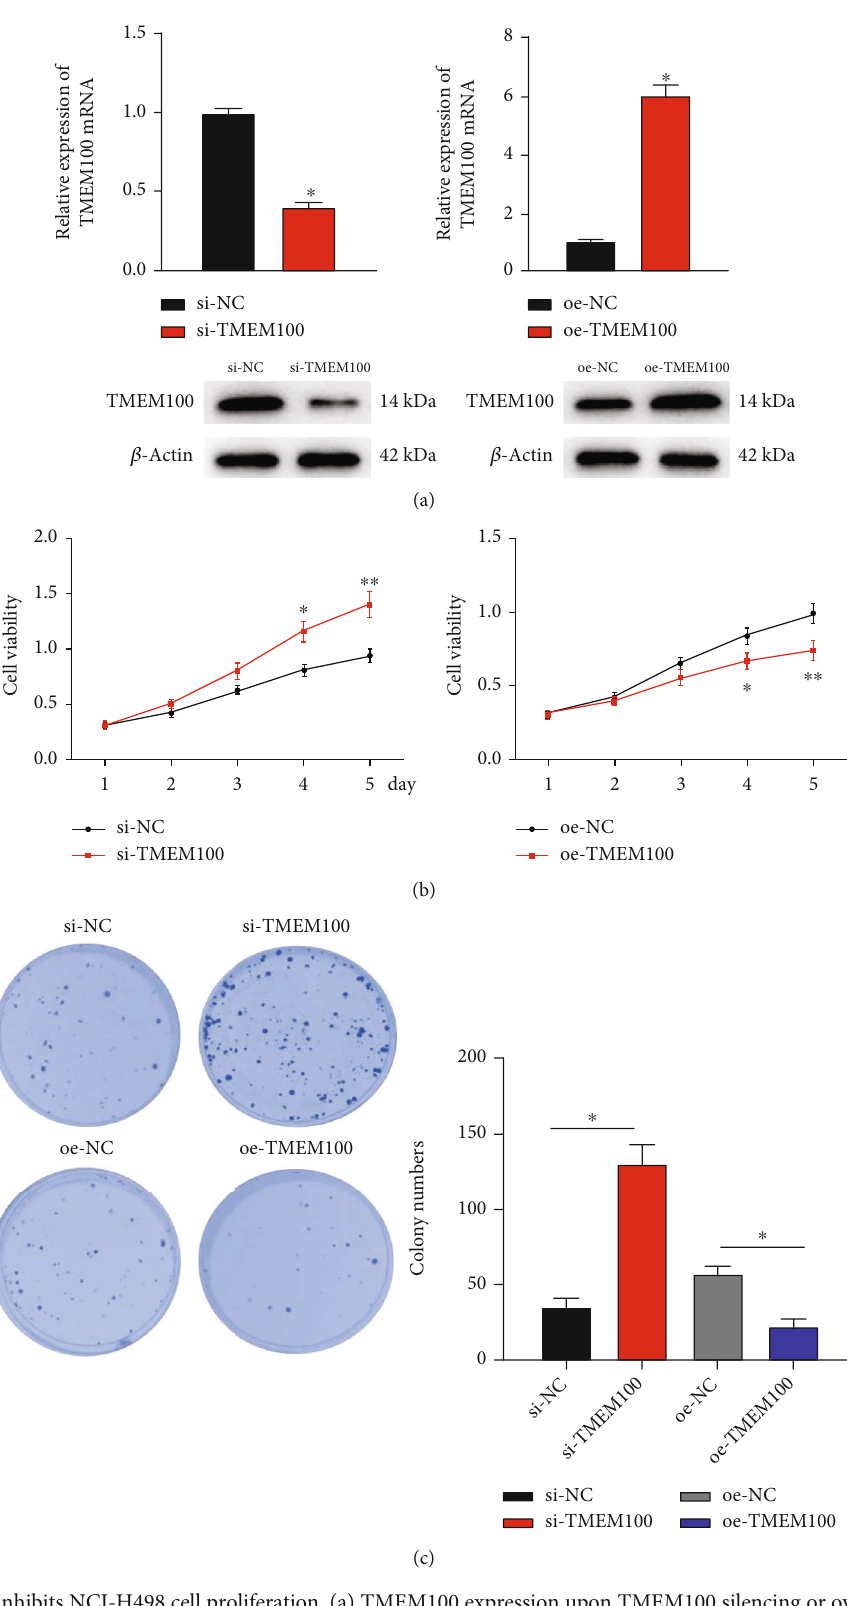
Figure 2: TMEM100 inhibits NCI-H498 cell proliferation. (a) TMEM100 expression upon TMEM100 silencing or overexpression analyzed by qRT-PCR. (b) MTT assay was performed to evaluate NCI-H498 cell proliferative ability upon TMEM100 silencing or overexpression. (c) The colony formation capacity of NCI-H498 cells upon TMEM100 silencing or overexpression was measured by colony formation assay. ∗ p < 0 : 05 , ∗∗ p < 0 : 01